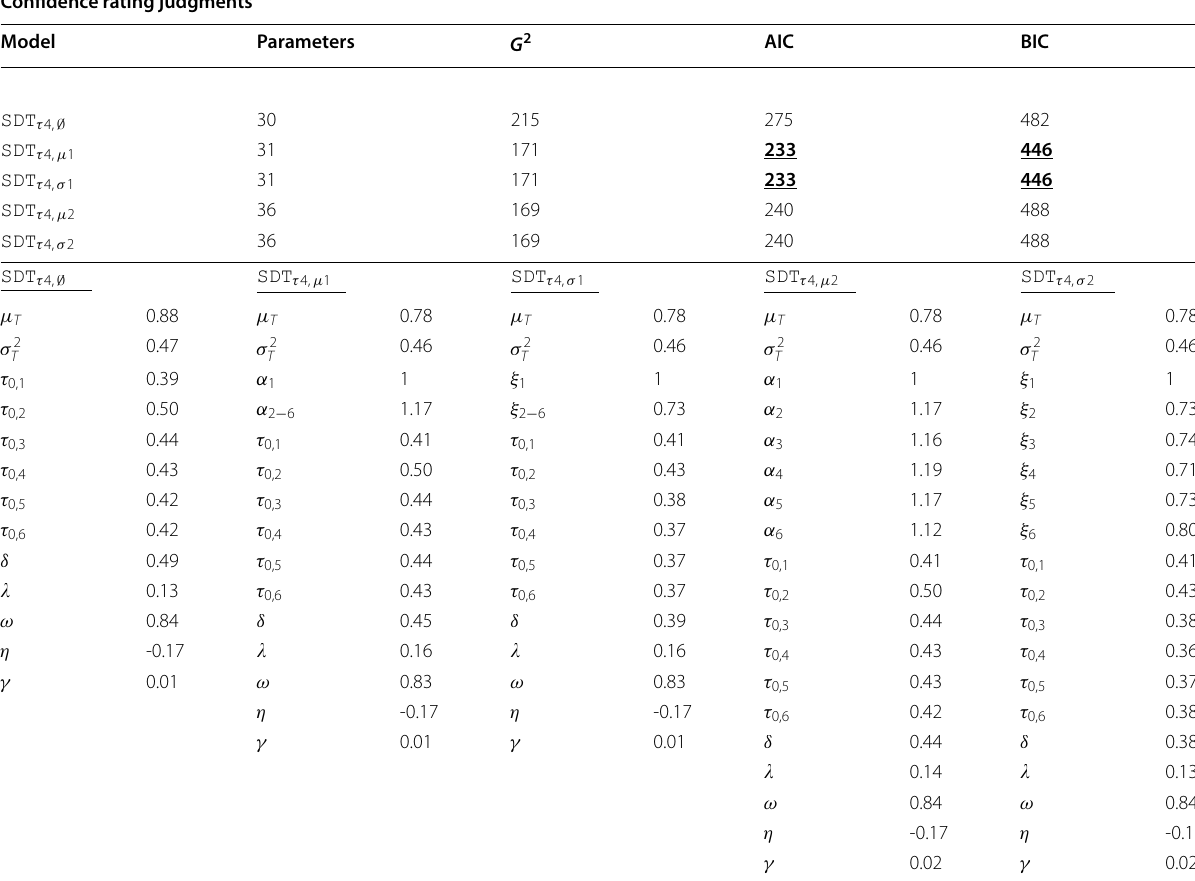
The best-performing values according to AIC and BIC are underlined and in bold font